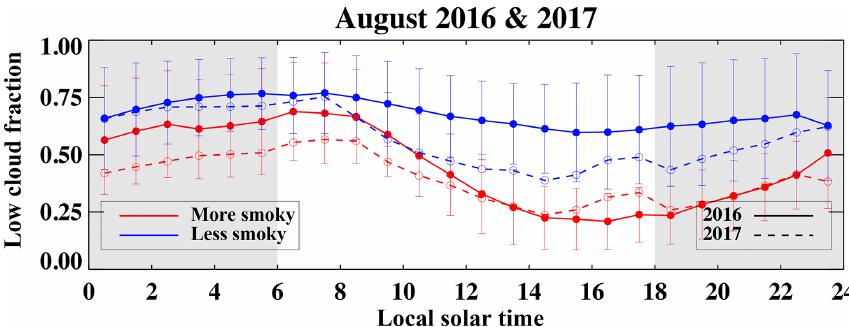
Figure 6. SEVIRI-derived hourly low-cloud fractions over 6–10 ◦ S, 11–15 ◦ W, composited by “more” (red) and “less” (blue) smoky days, for August 2016 (solid line) and 2017 (dashed line). Shown are mean values and the standard deviation of each composite group for that hour. Gray shading indicates nighttime.